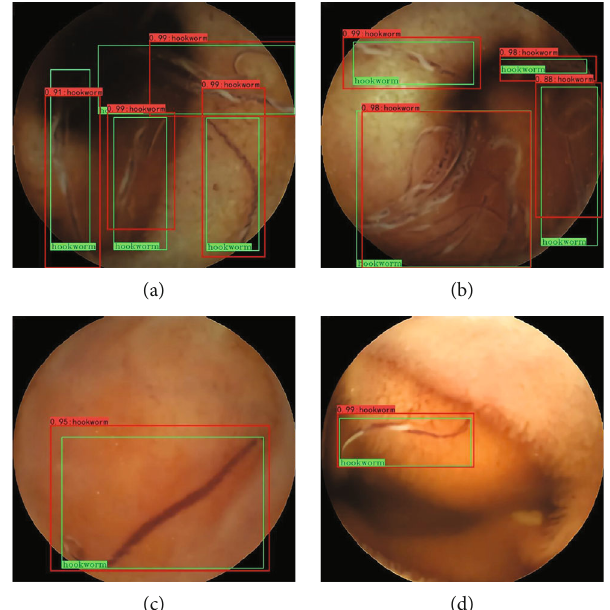
Figure 2: Representative images of multiple hookworms and single hookworm correctly detected by the convolutional neural network (CNN) in the validation set (green box, true lesion; red box, region identi fi ed as hookworms by the